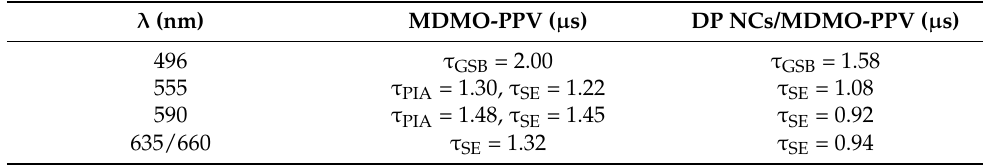
Figure 3. Transient absorption (TA) spectra at UVA excitation in toluene of ( a ) MDMO-PPV polymers, ( b ) DP NCs/MDMO-PPV nanocomposites, and ( c ) Mn-doped DP NCs, respectively. TA dynamic trajectories and their corresponding fitting curves for MDMO-PPV polymers (blue line) and DP NCs/MDMO-PPV nanocomposites (red line) at probe wavelengths of ( d ) 496 nm, ( e ) 555 nm, and ( f ) 590 nm, respectively. Table 1. Fitting parameters of TA trajectories in Figure 3d–f.